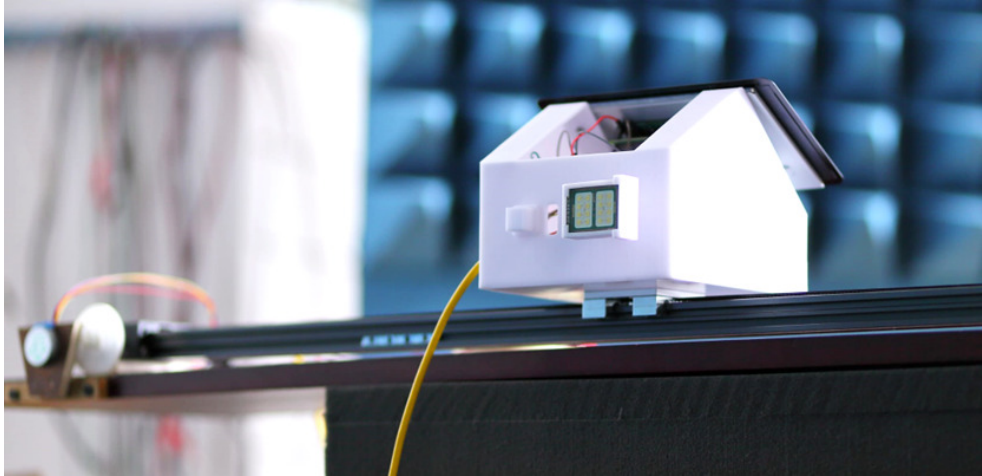
Figure 2. Developed